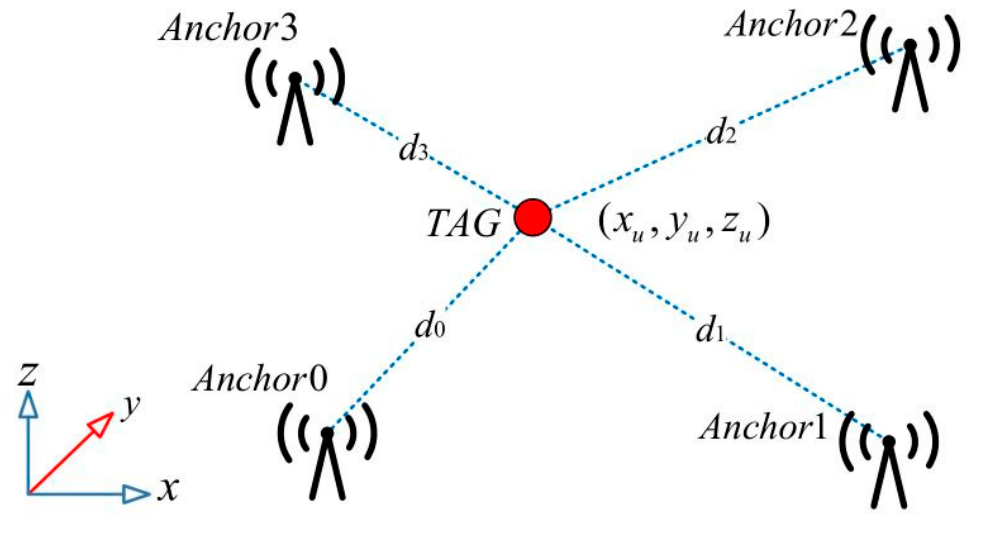
Figure 2. Positional relationship between the anchors and the tag.